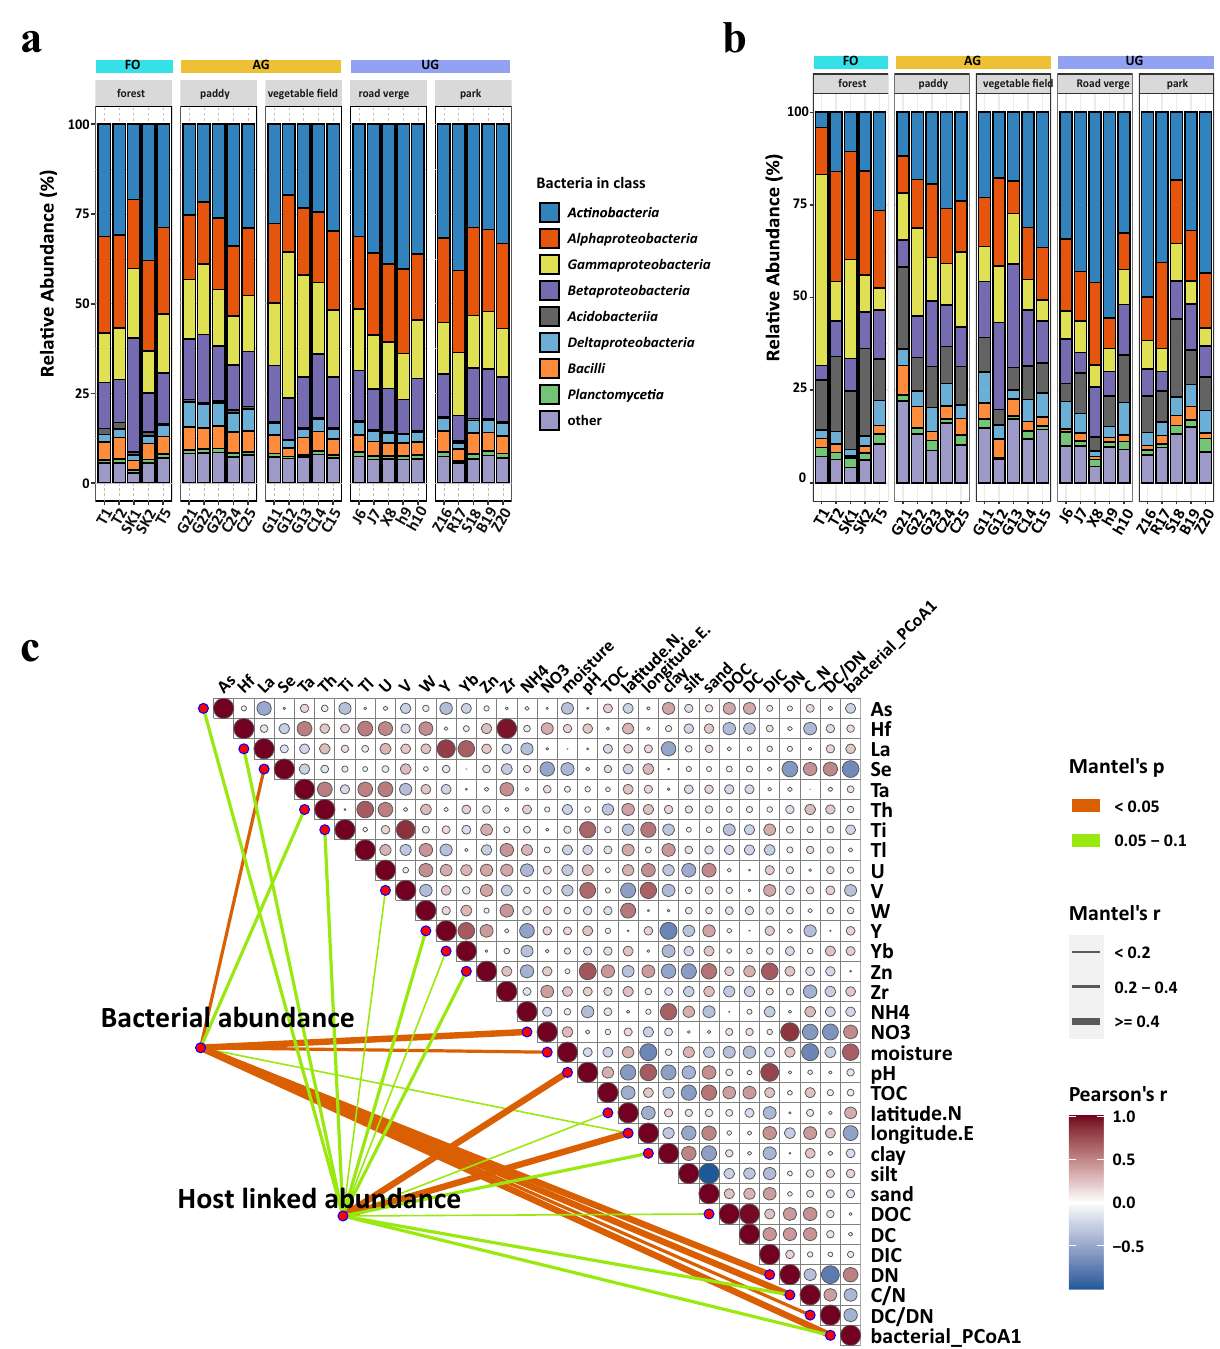
Fig. 5 | The relationship between bacteria, host-linked viruses and environ- mental factors. a Class distribution of bacterial compositions of metagenomes from various land use types. b Relative abundances of lineage-speci fi c phages grouped at the host class level. c Mantel test showed the correlation between environmental factors and lineage-speci fi c phages (top node, host-linked